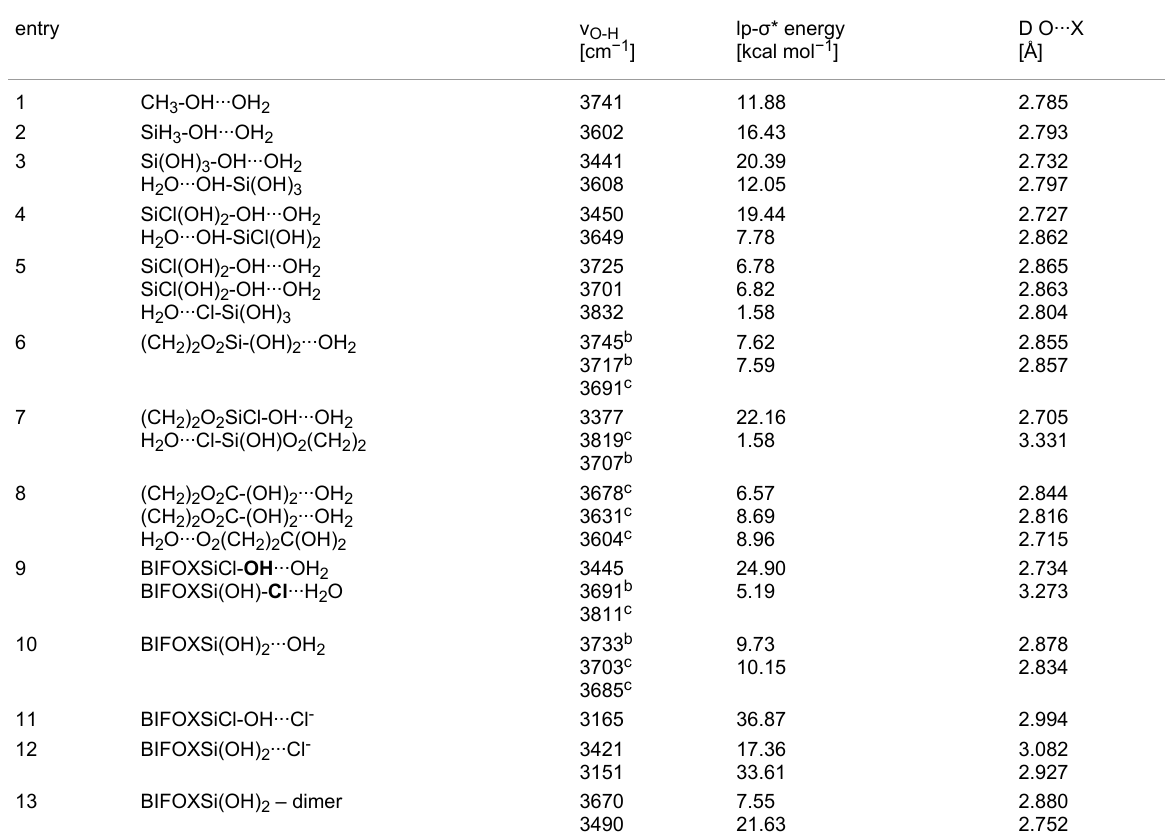
Table 4: Computed a stretching frequencies ( ν [cm − 1 ]), lp··· σ * [kcal mol − 1 ] and donor acceptor distances (D [Å]) of silanes 7 , 8 , [CH 2 O] 2 SiCl(OH),